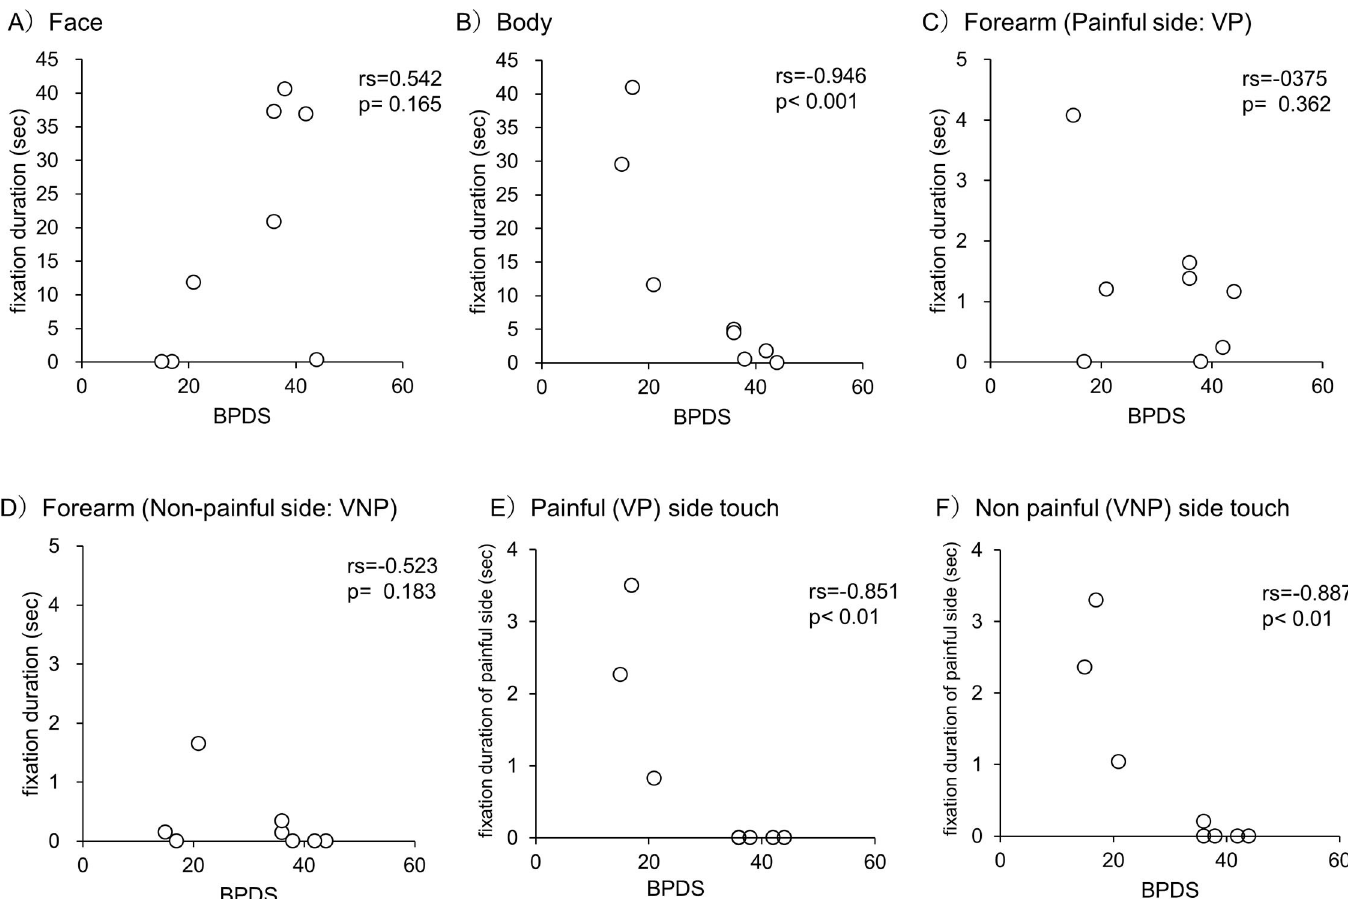
Fig 4. Correlation with BPDS and fixation duration. A-D): video clip 1, E, F): video clip 2. BPDS: Bath CRPS Body Perception Disturbance Scale, VP and VNP: VP and VNP refer to the side of the person in video 1 corresponding to the painful and non-painful side of the patients. VR and VL: VR and VL refer to the right and left side of the person in video